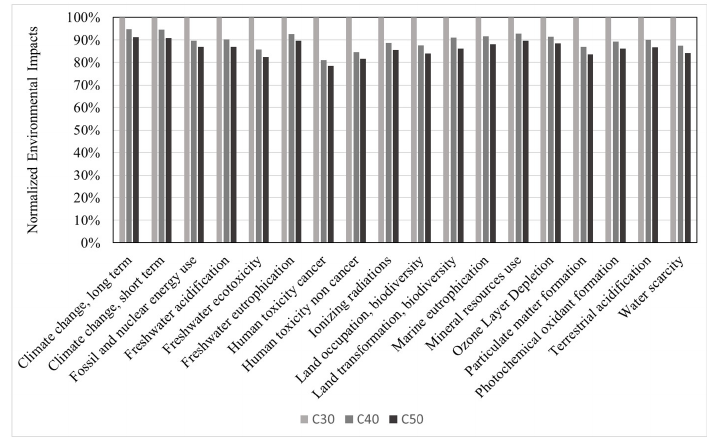
Figure 5. Normalized LCA results for RC